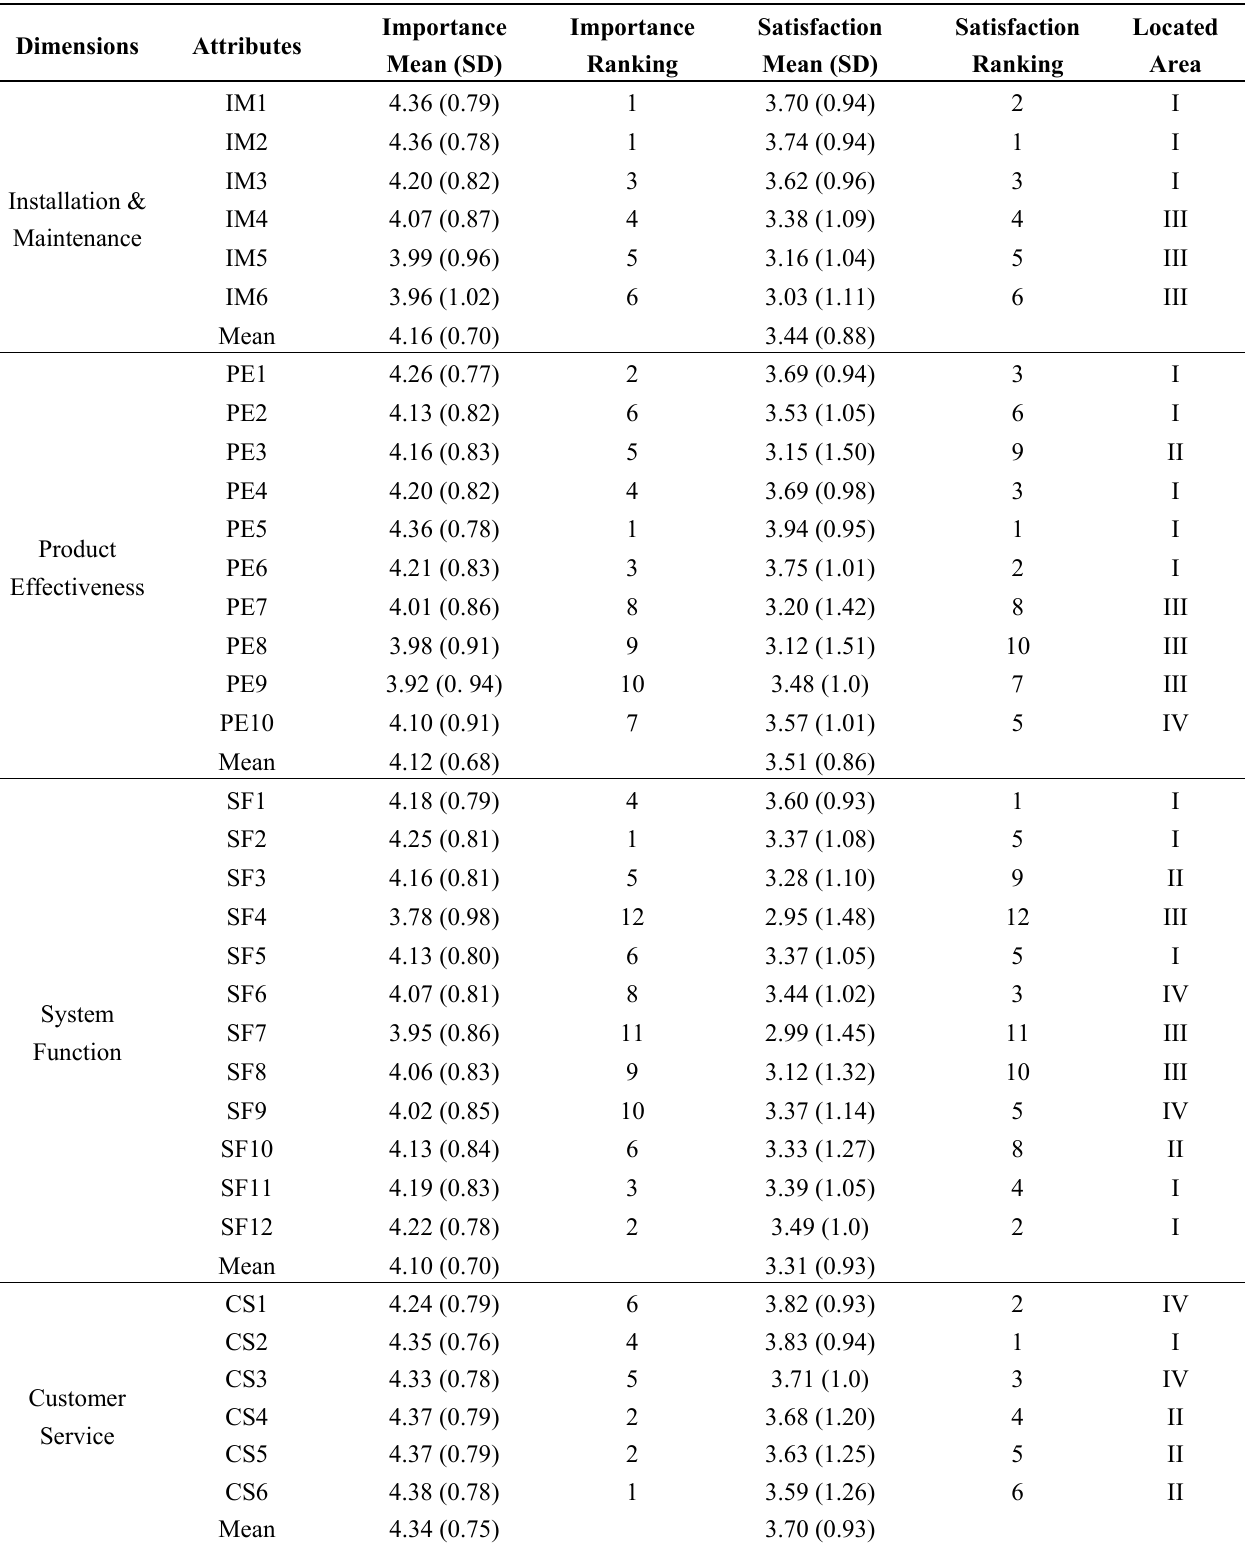
Table 3. Importance and satisfaction